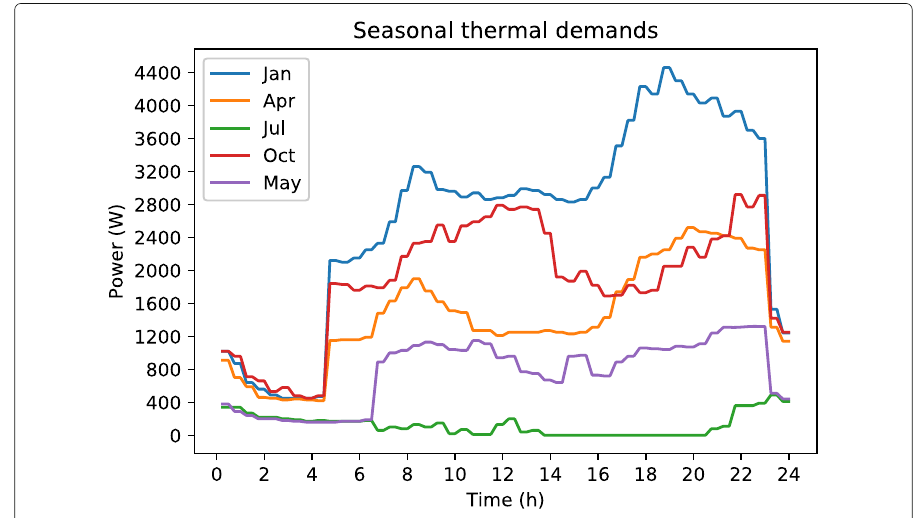
Fig. 5 Seasonal profiles of the thermal